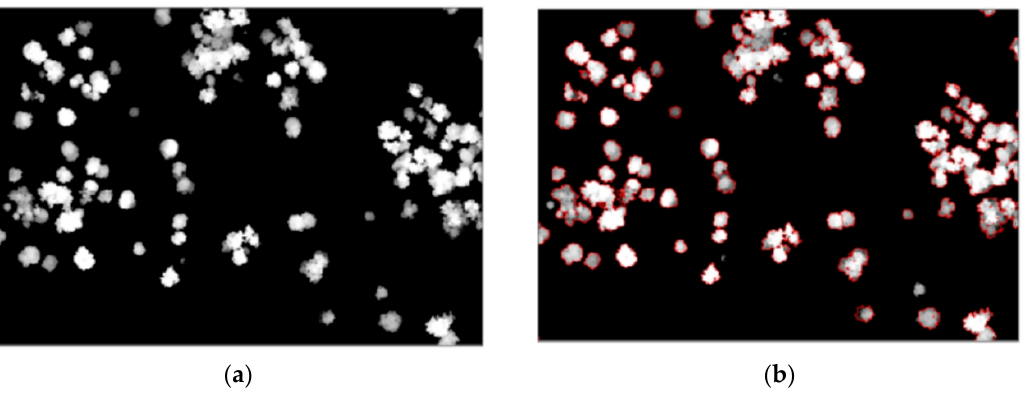
Figure 6. An example of the ( a ) LiDAR-derived canopy height model; and ( b ) the segmentation